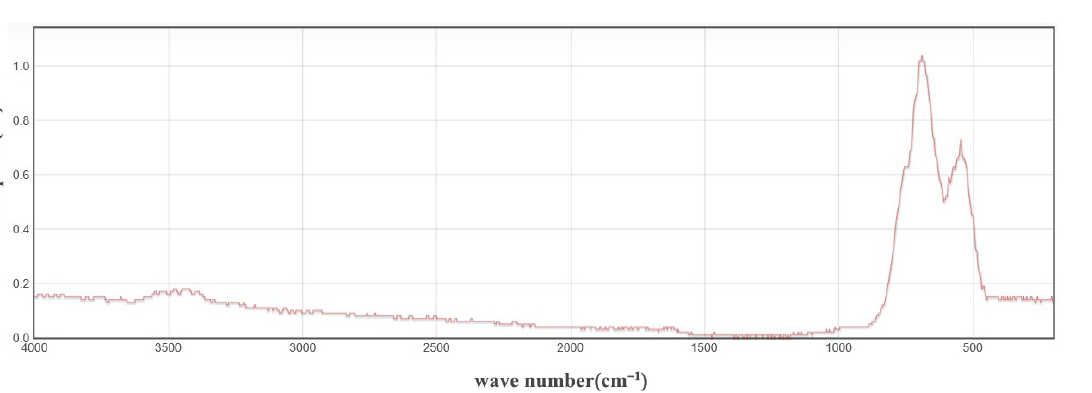
Figure 10. The absorbance spectrum of rutile TiO 2 .